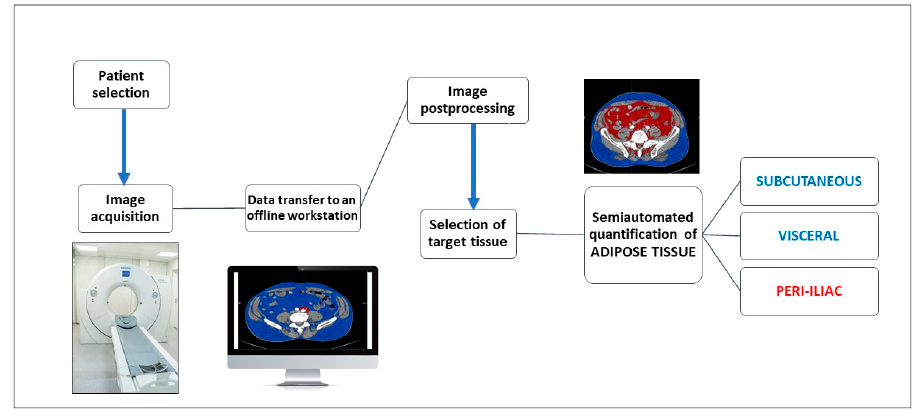
Figure 1. Flowchart of the computer aided image postprocessing steps.